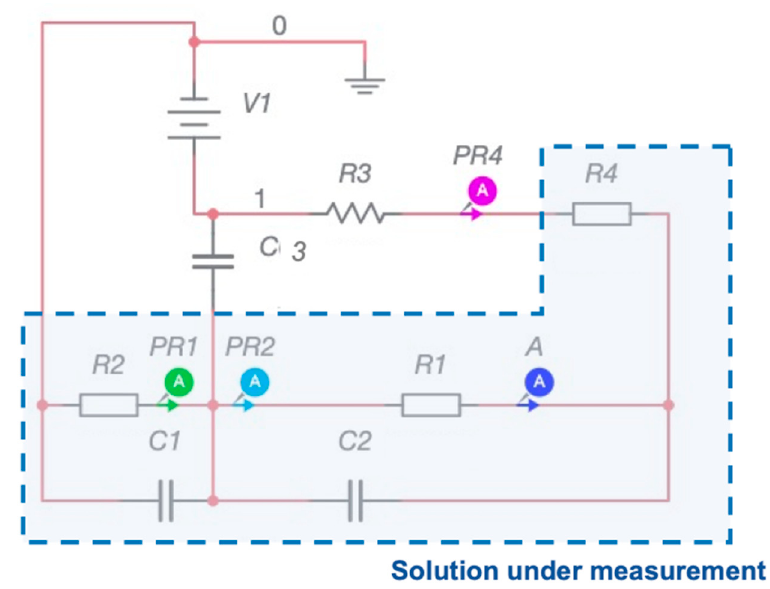
Figure 3. Schematic of the circuit used to control the BIONOTE-L device in a threshold modality.